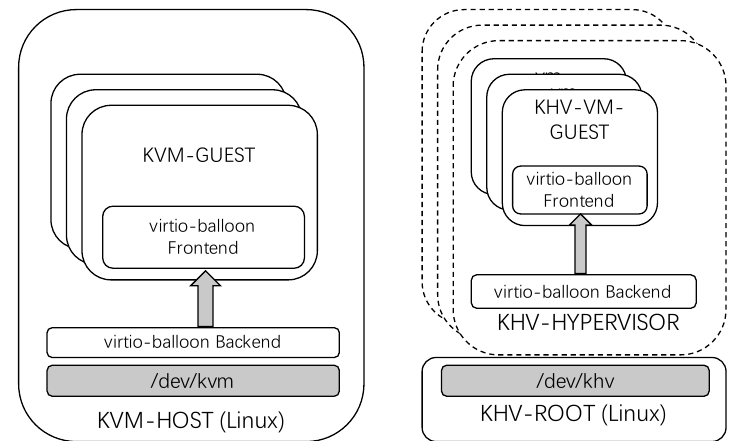
Figure 8. Virtio-balloon (KVM vs.